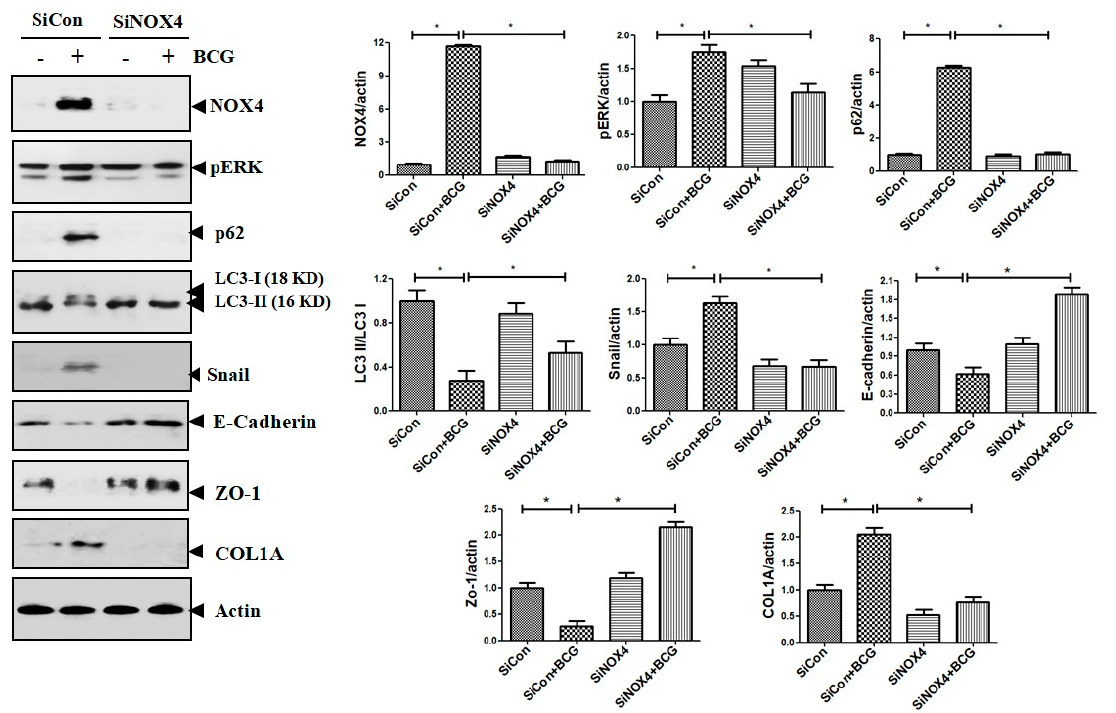
Figure 9. The effect of SiRNA post treatment in BCG-induced pleurisy model. The expression of NOX4, phosphorylated ERK, LC3II, P62, collagen, and EMT markers in mouse lung lysates after BCG infection and SiNOX4 post-treatment.